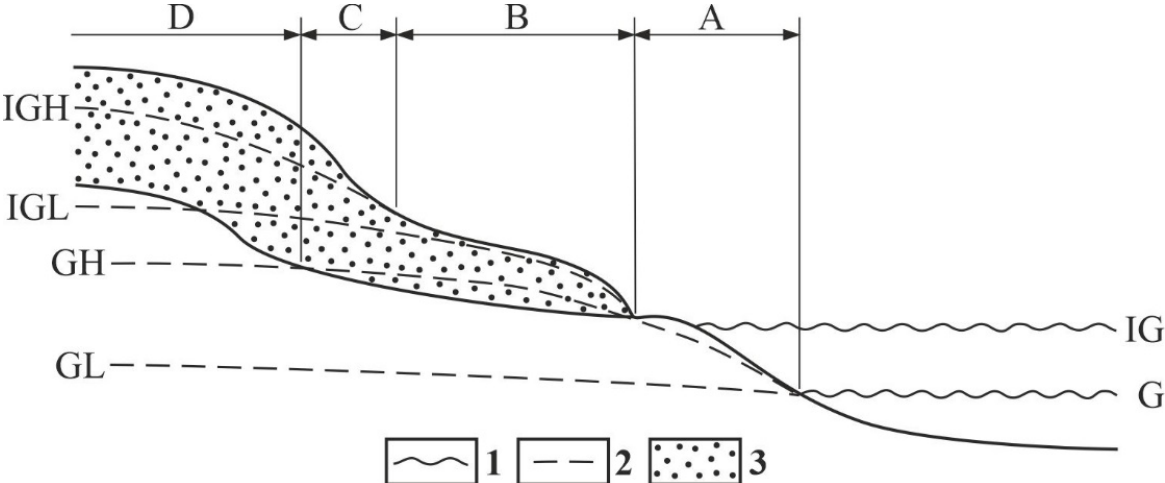
Figure 18. A possible model of doline development on coastal karst in glacials and interglacials 1. sea level, 2. karstwater level, 3. non-karstic permeable cover, G. sea level of glacial, IG. sea level of interglacial, GL. low karstwater level during glacial, GH. high karstwater level in glacial, IGL: low karstwater level in interglacial, IGH. high karstwater level in interglacial, ( A ) zone of solution dolines, ( B ) zone of dropout dolines that developed in the glacial, the dolines of which are transformed into dolines with lakes in the interglacial, ( C ) zone of dropout dolines that developed in the glacial, ( D ) zone of suffosion dolines that developed in the glacial, in which dropout dolines may develop in the interglacial.